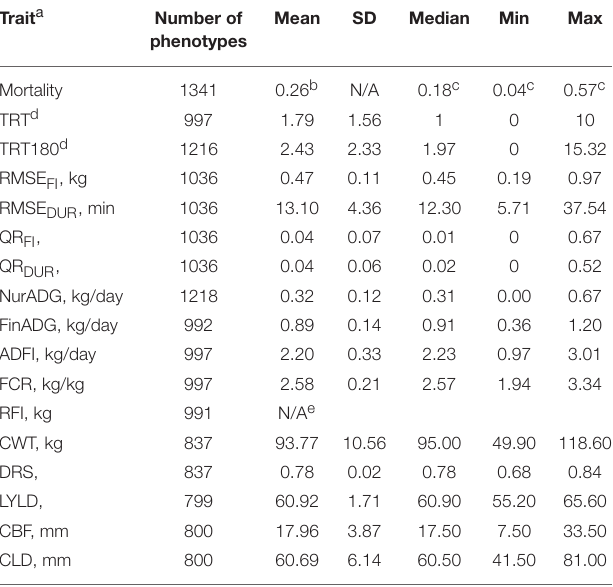
TABLE 2 | Summary statistics of the analyzed traits ( n = 1,341 total animals). Trait